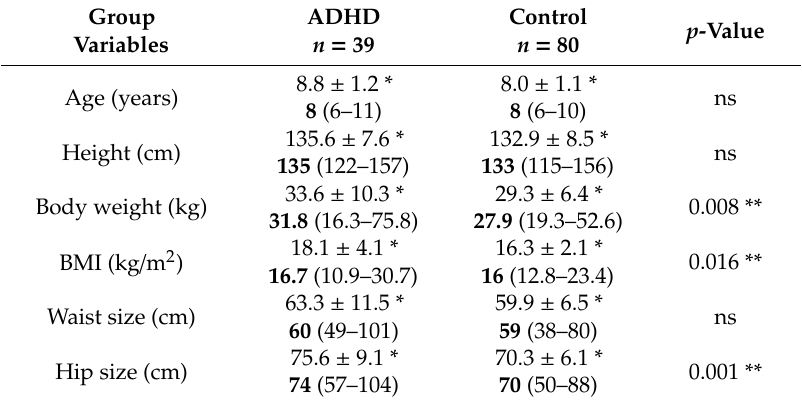
Table 2. Selected statistics of developmental parameters for ADHD and control